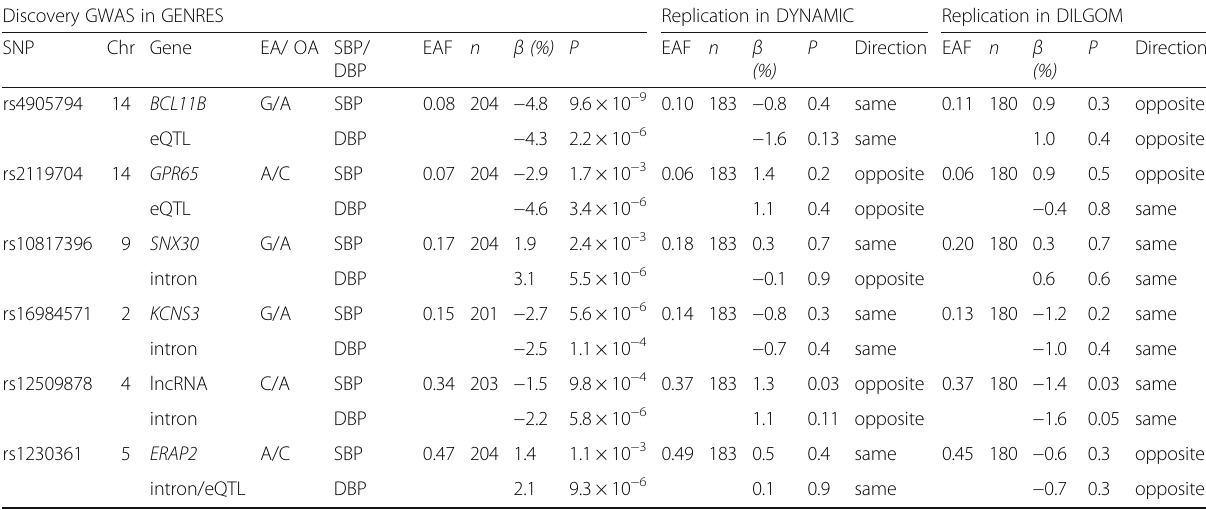
Table 2 Top SNPs associated with blood pressure dipping (night-to-day blood pressure ratio) in GENRES and replication in DYNAMIC and DILGOM Discovery GWAS in GENRES Replication in DYNAMIC Replication in